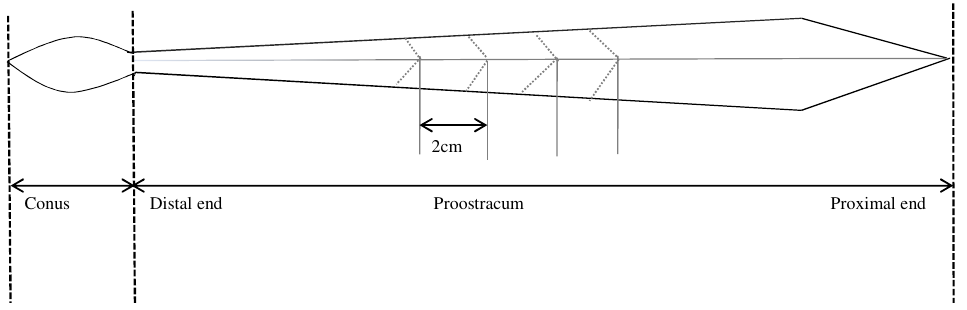
Figure 2. Structure of the Todarodes pacificus gladius.